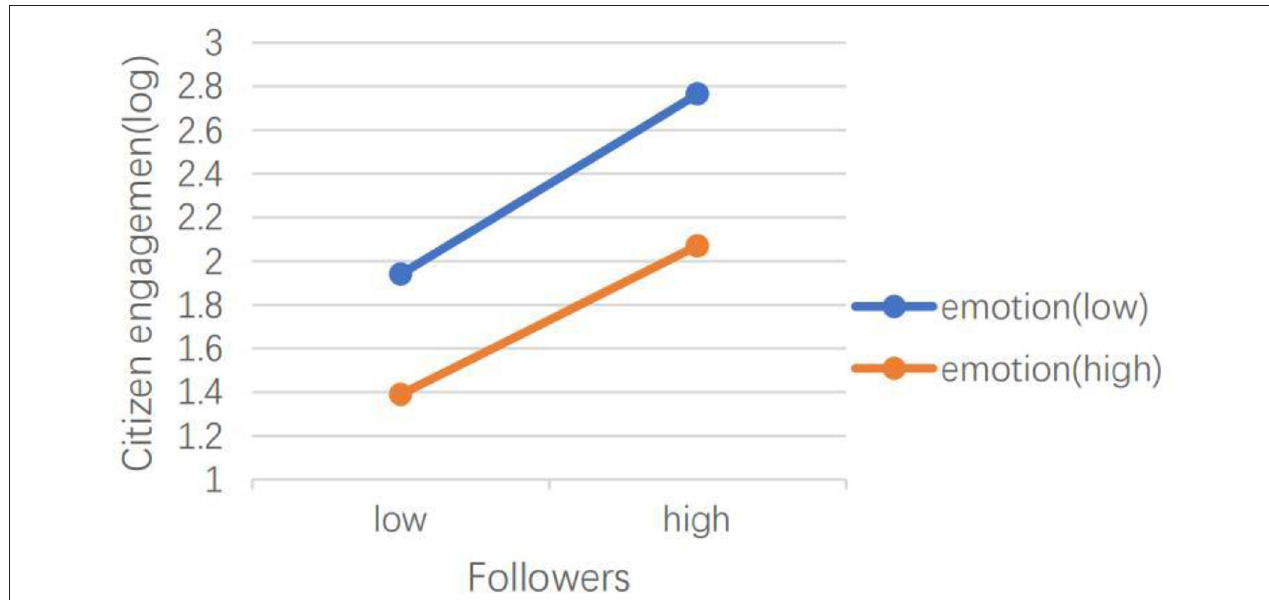
FIGURE 3 | Two-way interaction between the number of followers and emotional valence in predicting CEGSM in the initial containment stage.